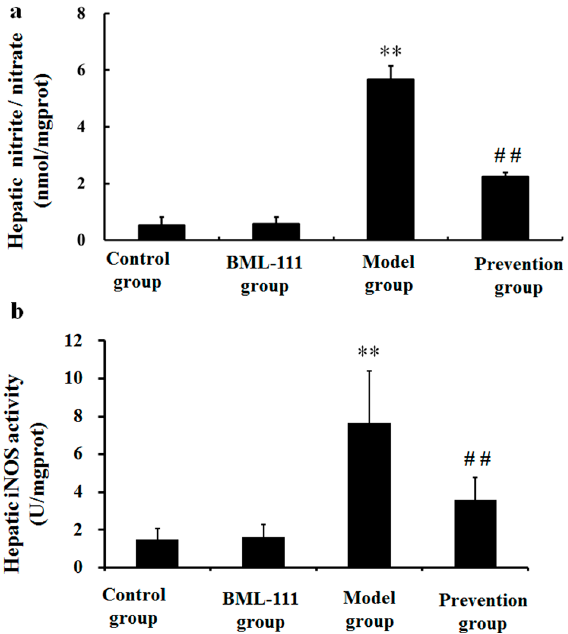
Figure 7. BML-111 inhibited LPS/ D -GalN induced NO and iNOS activity. ( a ) The contents of NO were tested via assay kit at 8 h after being challenged with LPS/ D -GalN; ( b ) The activities of iNOS were analyzed via assay kit at 8 h after LPS/ D -GalN injection. ** p < 0.01 compared with the control group, and ## p < 0.01 compared with the model group ( n = 6).